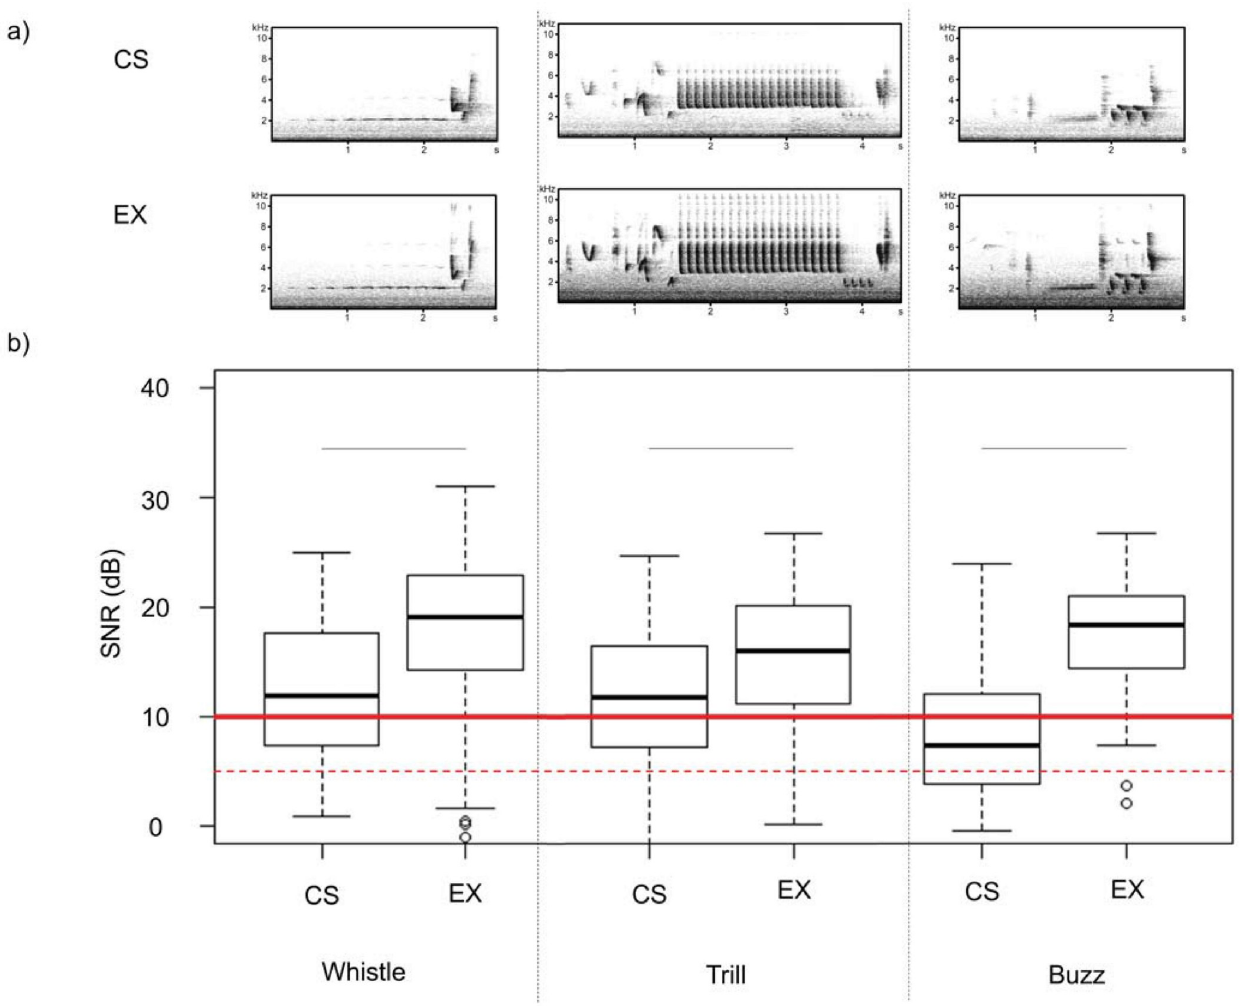
Fig 6. Comparison of citizen science (CS) recordings with the ’Naturblick’ app and expert recordings with equipment using professional microphones (EX) in the year 2018 and 2019. a) Spectrograms of CS recordings (top) compared to EX recordings (below) for the one example per song categories (whistle, trill and buzz). b) Comparison the signal to noise ratio (SNR) as boxplots for three of these selected song types per each category: whistle (left), trill (middle) and buzz (right). The median of the boxplot is represented by a solid black line and the mean by a dashed black line within a box. The borders of boxes are 25 and 75 percentiles. The bars above box plots indicate significant differences between two stimulus categories. SNRs over 10 dB (red line) were defined in this study as valid quality according to Fitzpatrick and colleagues [58]. The red dotted line indicates a value of 5 dB, a threshold used by Barmatz and colleagues [57, 58] for valid quality. The black lines indicate significant differences. All recordings were examined and displayed under the same settings (sample rate = 22,050 Hz, FFT = 1024 points, Hamming-Window, overlap 93,75%).